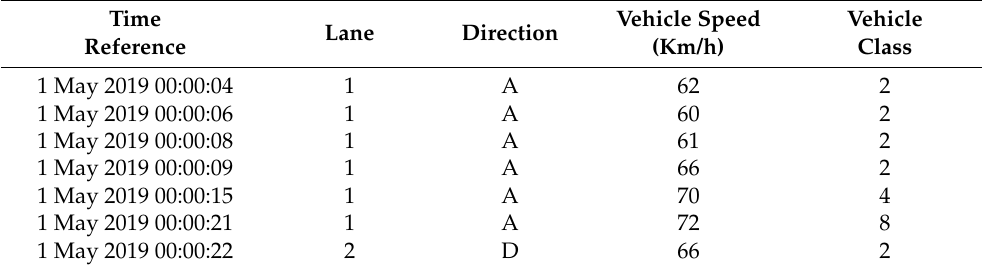
Table 1. Example of Control unit traffic survey.